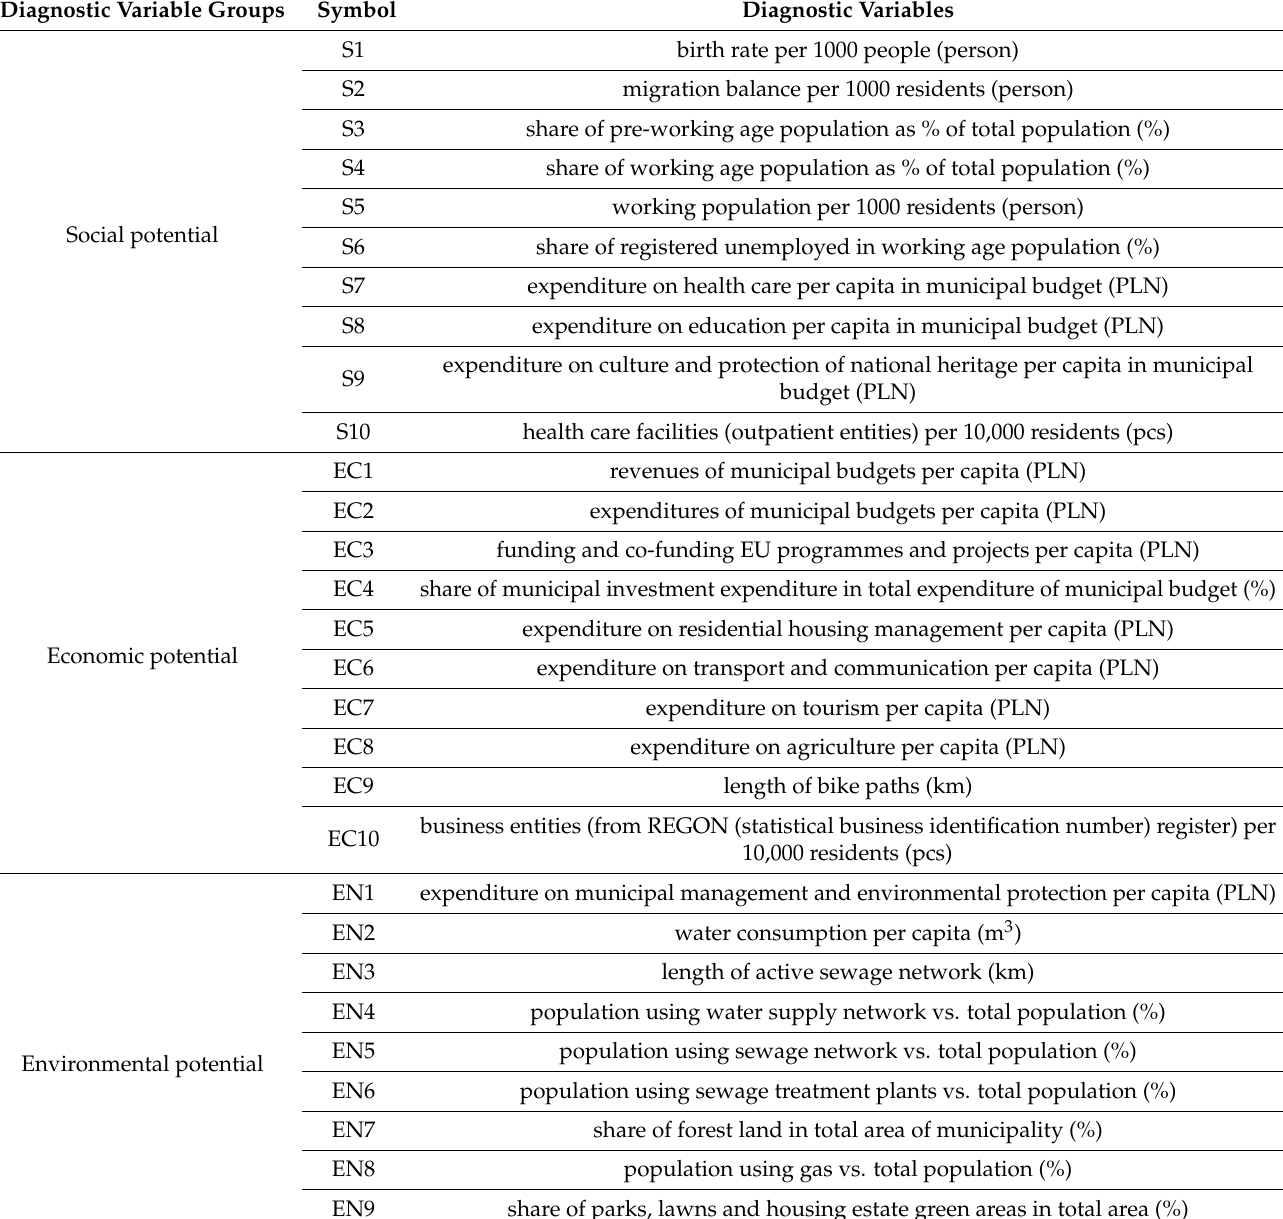
Table 1. Diagnostic variables adopted in the